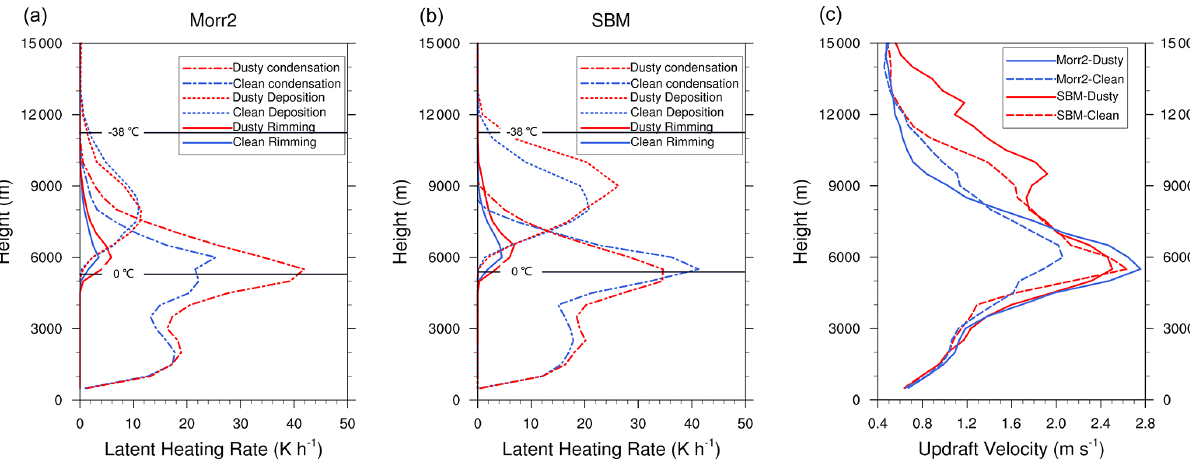
Figure 9. Vertical profiles of latent heating rates averaged over the top 10th percentiles of the updrafts ( w > 0.5ms − 1 ) from (a) Morr2-Clean (blue lines) and Dusty (red lines), and (b) SBM-Clean (blue lines) and Dusty (red lines) in High-Pcp area during 12:00–16:00LT (P2). (c) Similar time–space-averaged vertical profiles of updraft velocity averaged over the top 10th percentiles of the updrafts (90th to 100th, with w (cid:38) 0.5ms − 1 ) simulated by Morr2-Clean and Dusty (blue) and SBM-Clean and Dusty (red).